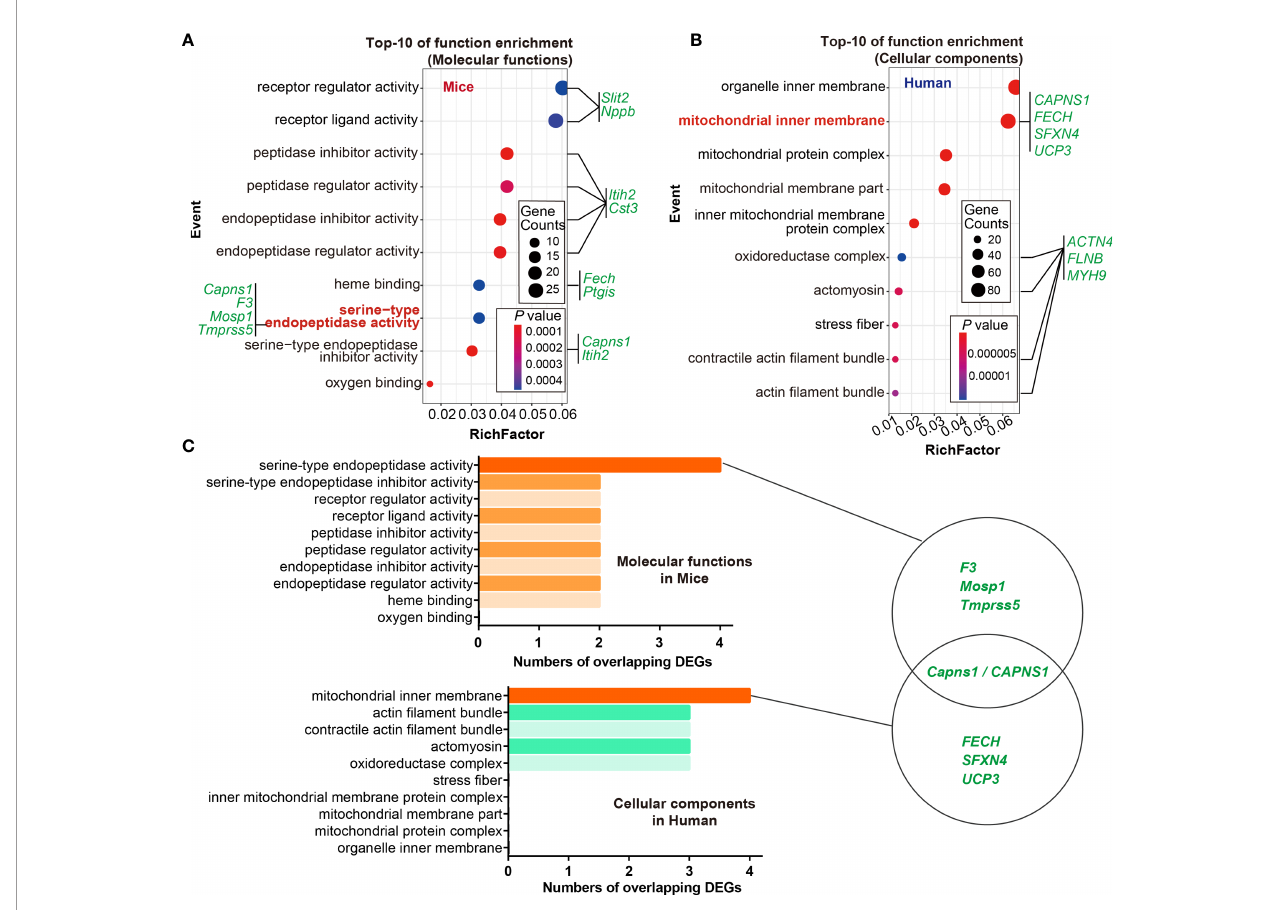
FIGURE 2 | GO functional enrichment and module analysis of DEGs in the three datasets. (A, B) Bubble maps showed the top-10 GO events associated with DEGs of molecular functions module and cellular components module. Signi fi cantly enriched functions of two modules were indicated in Y -axis. Rich factor in the X -axis represented the enrichment levels. The larger value of Rich factor represented the higher level of enrichment. Color of the dot stands for the different P -value and size of the dot re fl ected the number of target genes enriched in the corresponding functions. Green letters in both modules indicated the overlapping DEGs. (C) Frequency of crucial overlapping DEGs ( ≥ 2 times) associated with top-10 events in both modules through GO analysis. There are seven crucial genes in T2D hearts according to the gene abundance grades in single event among the top-10 GO events, including Capns1, F 3, Mosp1 , Tmpress5 in cellular components module, and CAPNS1 , FECH , SFXN4 , UCP3 in molecular function module. P < 0.05. Schematics of GO analysis of overlapping DEGs for datasets GSE150316, GSE133054, and GSE161931 from NCBI-GEO (left panel). The richest DEGs enriching in corresponding functions showed in circles, and CAPNS1 was the unique crucial gene shared by both modules (right